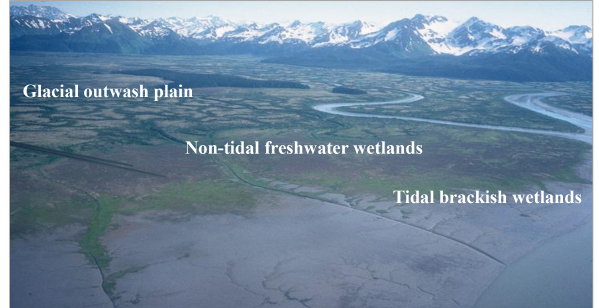
Figure 2. Aerial photo of the Copper River delta taken by the USDA Forest Service depicting the major wetland ecosystem types extend- ing from glaciers to